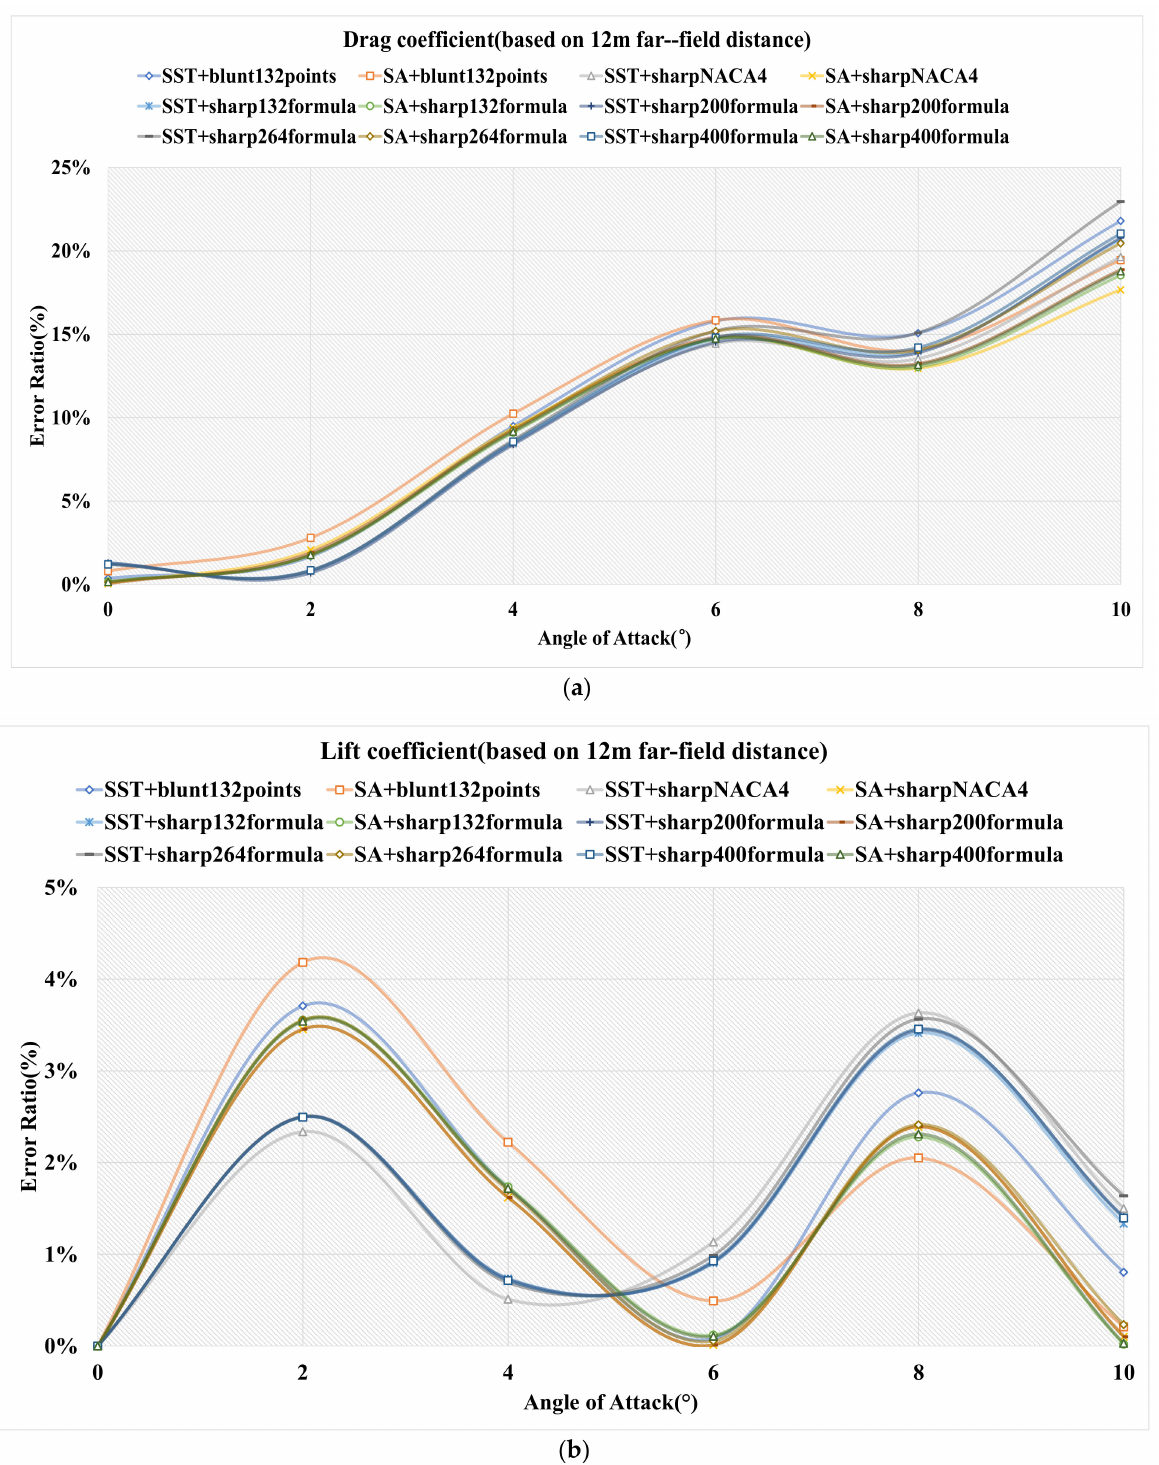
Figure 12. ( a ) Drag coefficient based on 12 m far-field distance; ( b ) lift coefficient based on 12 m far-field